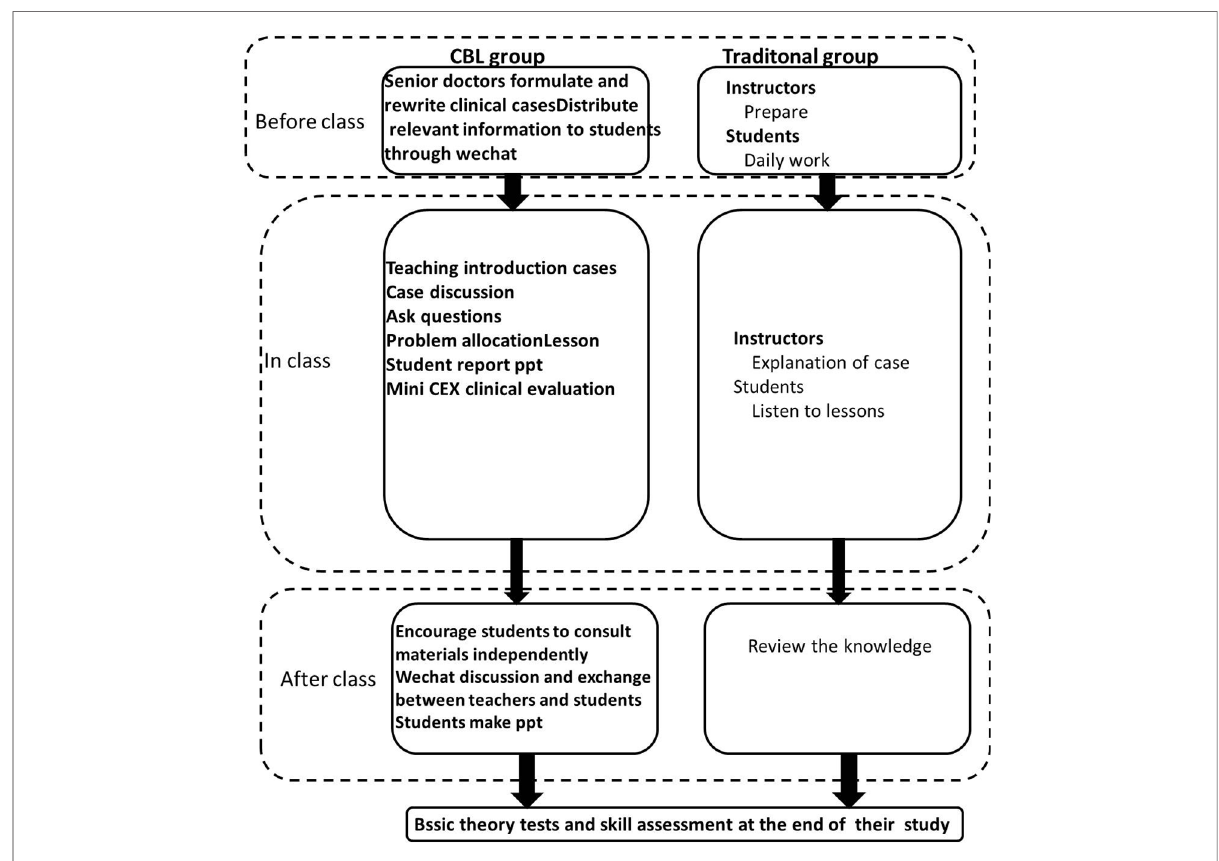
FIGURE 1 Teaching fl ow chart of CBL group and traditional teaching